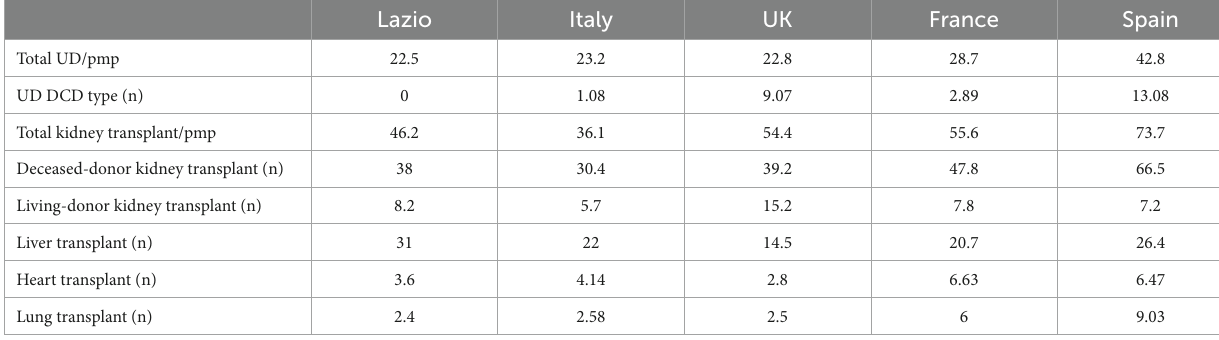
TABLE 3 Summary of 2019 Organ Donation and Transplantation activity (rate/pmp) in Lazio Region, Italy, UK, France, and